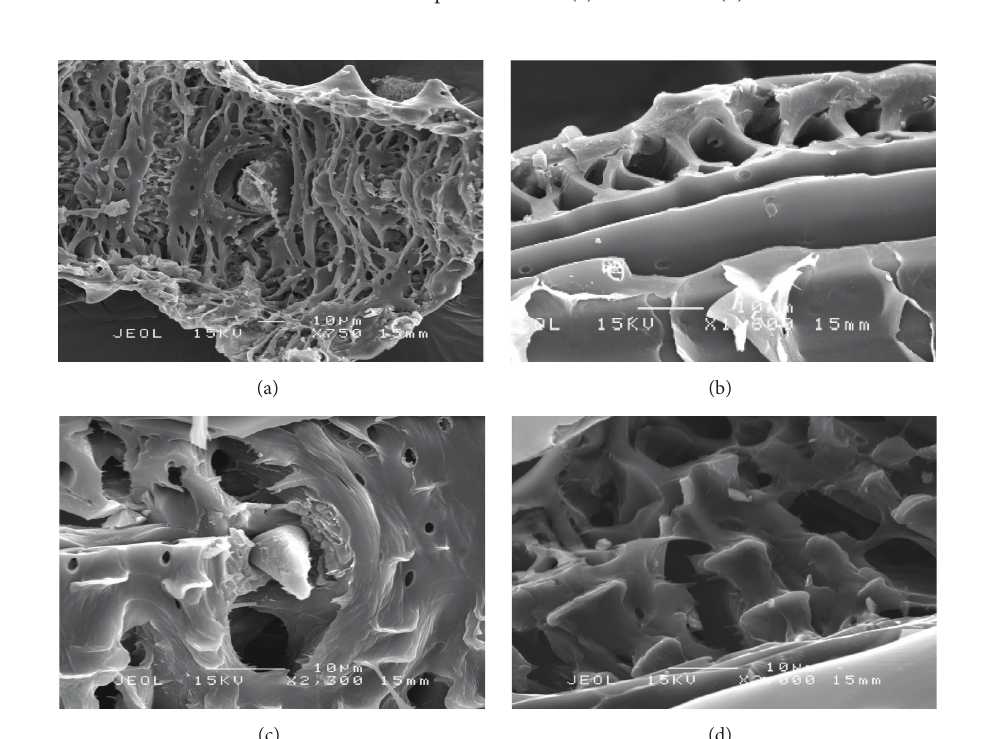
Figure 2: The scanning electron microscope images of the RHA magnified at 750 (a), 1600 (b), 2300 (c), and 3000 times (d). The accelerating voltage of the instrument was maintained at